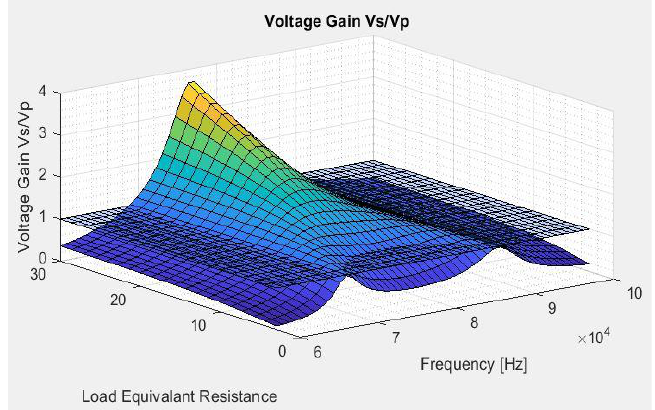
Figure 6. 𝐺 𝑣 Simulated with 𝐶 𝑝 = 𝐶 𝑠 = 66[nF];𝐿 𝑝 = 𝐿 𝑠 = 65[μH];𝑟 𝑝 = 𝑟 𝑠 = 60[mΩ]; 𝑉 𝑑𝑐 = 60 [V];𝑘 = 0.25 . 60 [ V ] ; k =